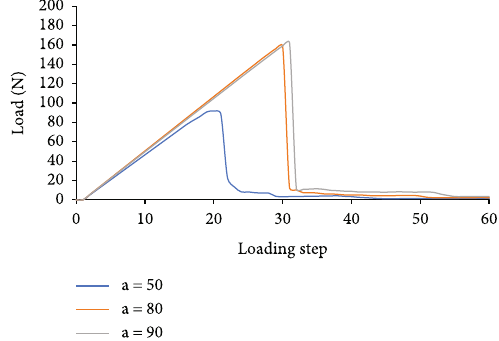
Figure 8: a is the force-loading step change curve of 50, 80, and 90 mm concrete three-point bending